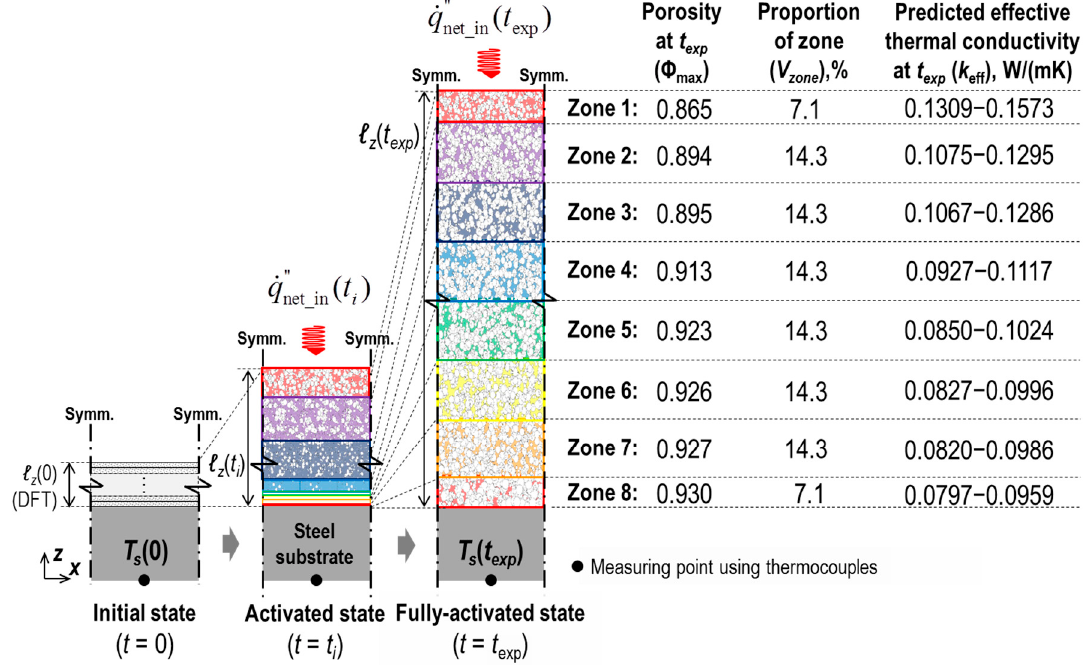
Figure 14. Schematic of concept of the FEA multilayer model for intumescence over time in association with the electric furnace test.